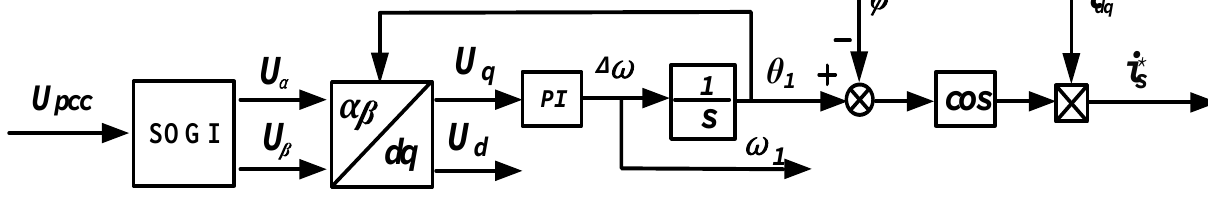
Figure 4. Phase locked loop control model.